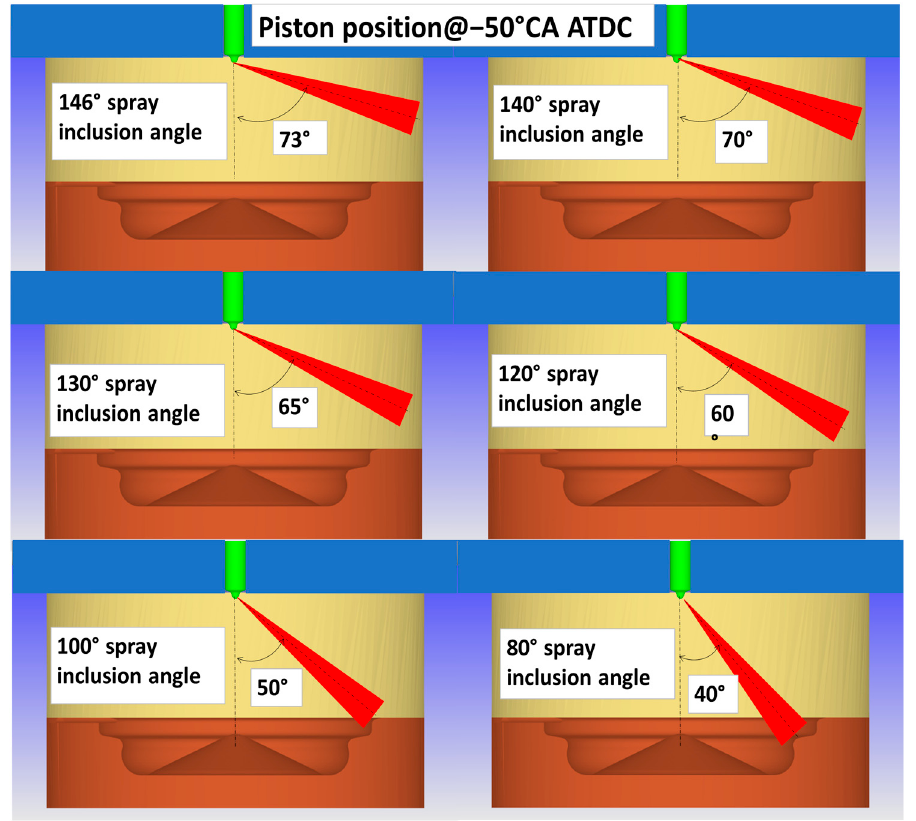
Figure 24. Interaction of fuel spray with the cylinder liner and piston bowl for various SIAs for SOI of − 50 °CA ATDC.